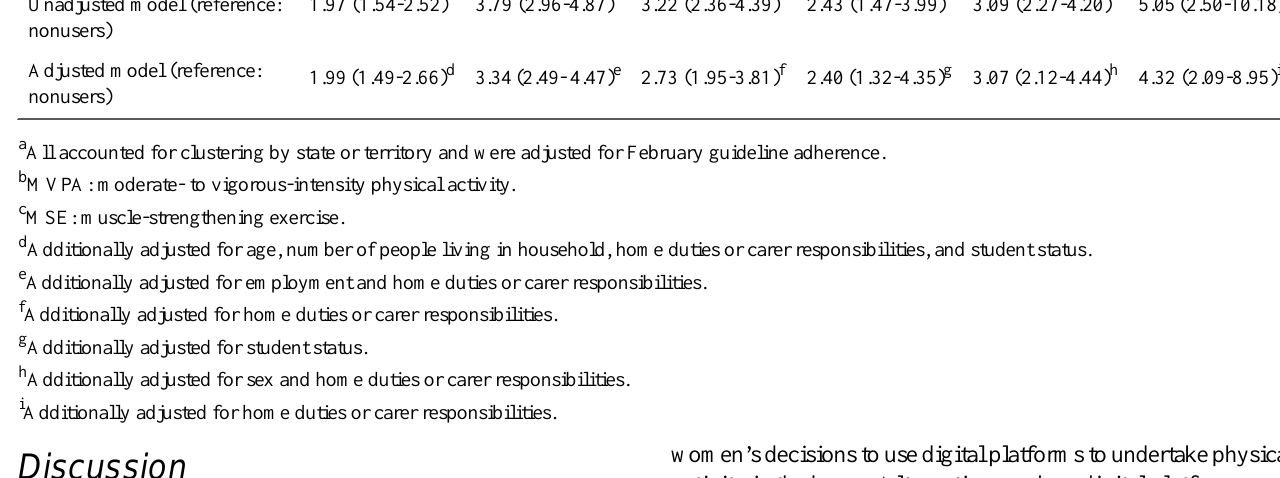
Digital platform use for adolescents, OR (95% CI) a Digital platform use for adults, OR (95% CI) a